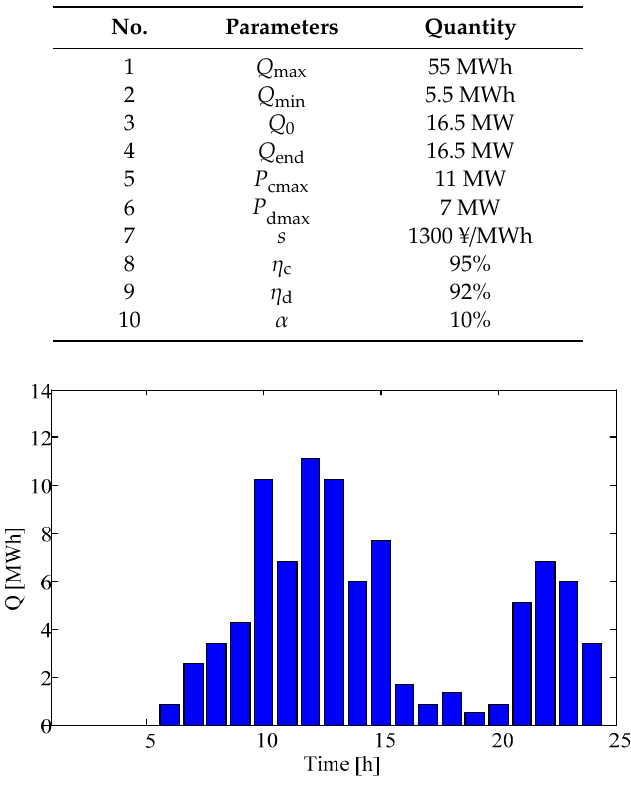
Figure 2. Prediction of battery-swapping demand.